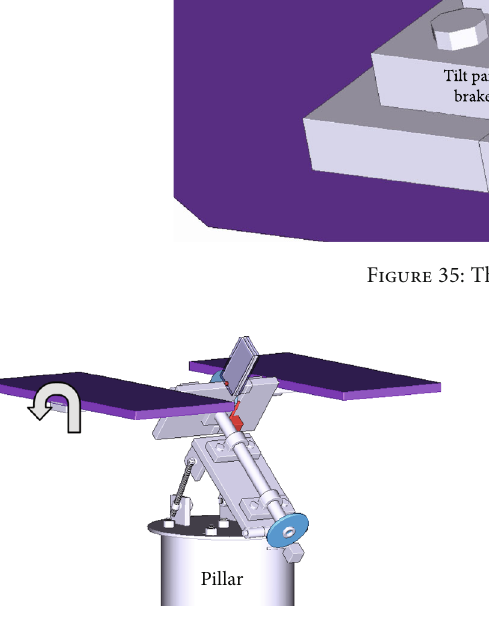
Figure 36: The solar tracker in the tilt parking position.